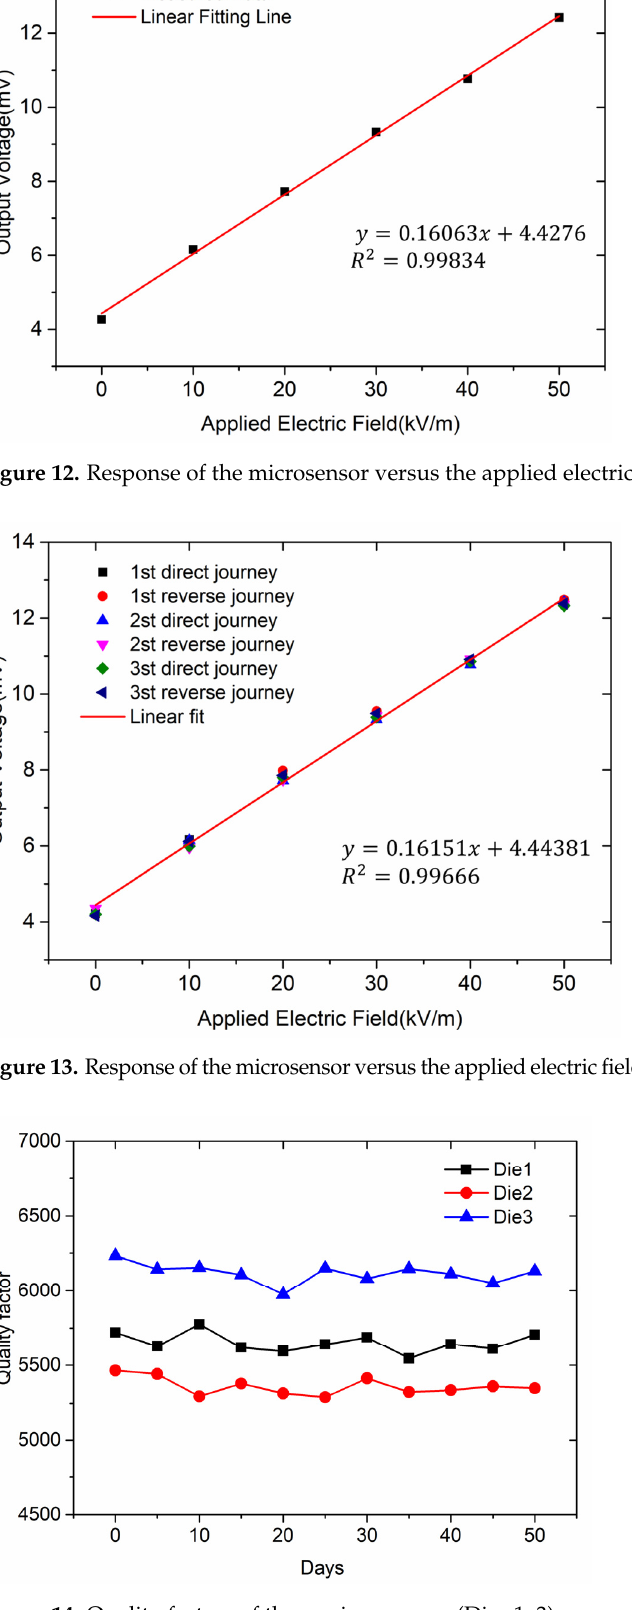
Figure 14. Quality factors of three microsensors (Dies 1–3) versus time.